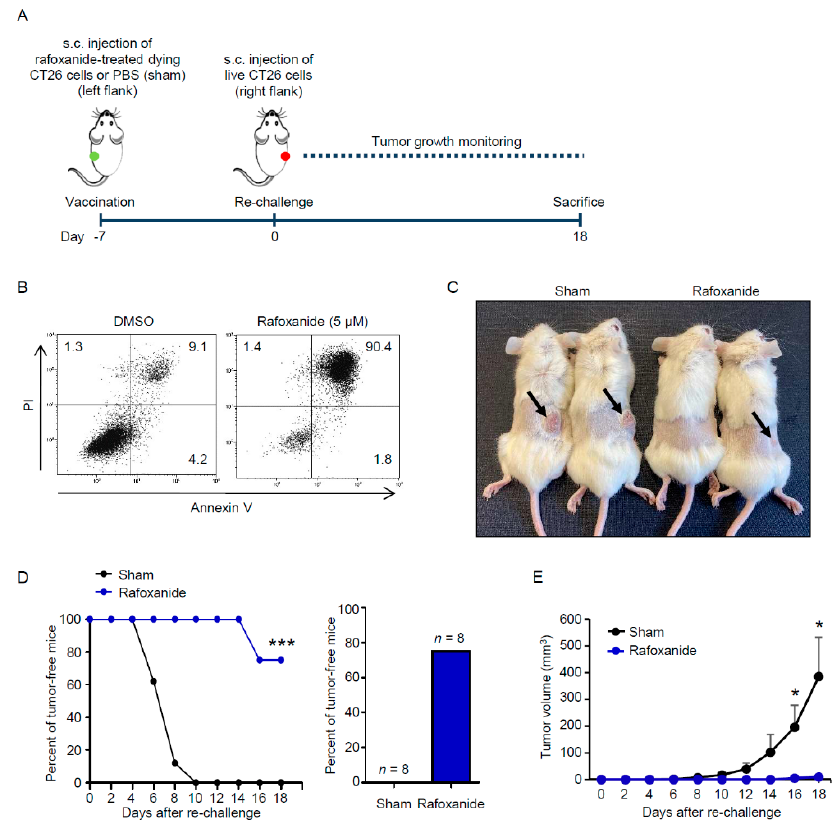
Figure 6. Rafoxanide has anti-cancer vaccination e ff ect on CRC. ( A ). Experimental protocol of the tumor vaccination model. CT26 cells were treated with 5 µ M rafoxanide for 48 h. Then the cells were collected and subcutaneously (s.c.) injected (1 × 10 6 cells per mouse) into the left flank of immunocompetent BALB / c mice (vaccination). An equal volume of PBS was used as control (sham). One week later (day 0), all mice were re-challenged with living CT26 cells (1 × 10 6 per mouse) into the right flank to test the elicitation of immunological memory. Tumor growth was monitored until sacrifice (day 18). ( B ). Representative dot-plots showing the percentages of AV- and / or PI-positive CT26 cells treated with either DMSO (vehicle) or 5 µ M rafoxanide for 48 h. Rafoxanide-treated CT26 cells were collected and used for in vivo vaccination as indicated in A. ( C ). Representative images of immunocompetent BALB / c mice vaccinated with either rafoxanide-treated succumbing CT26 cells or PBS (sham) and then re-challenged with living CT26 cells as indicated in A. Mice were sacrificed 18 days after the re-challenge. Arrows indicate CT26-derived tumors growing at the re-challenge site. ( D ). Evolution of tumor incidence over time as a Kaplan–Meier curve in mice treated as indicated in A. Shown is the percentage of tumor-free mice pooled from 2 independent experiments ( n = 8 mice per group). Statistical significance was calculated by log-rank (Mantel-Cox) test. *** p < 0.001, as compared to mice vaccinated with PBS (sham). The right inset indicates the percentage of mice that were tumor-free at the end of the protocol (day 18). Data are derived from two independent experiments and the number of animals globally employed for these determinations is indicated. ( E ). Evolution of tumor growth over time. Tumor volume is represented as mean + SD. Statistical significance was calculated using the two-tailed Student’s t -test. * p < 0.05, as compared to mice vaccinated with PBS (sham).